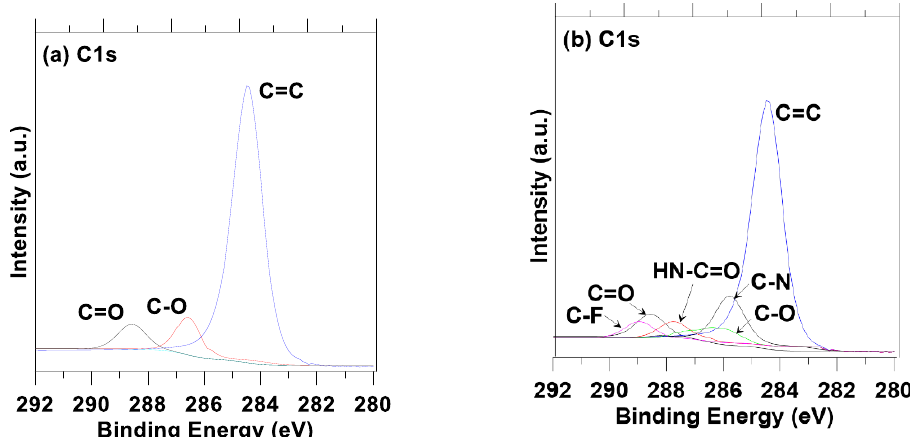
Figure 3. XPS spectra of the following: ( a ) Pristine pre-lithiated graphite and carbon black anode; ( b ) Polymer composite coated pre-lithiated graphite and carbon black anode.